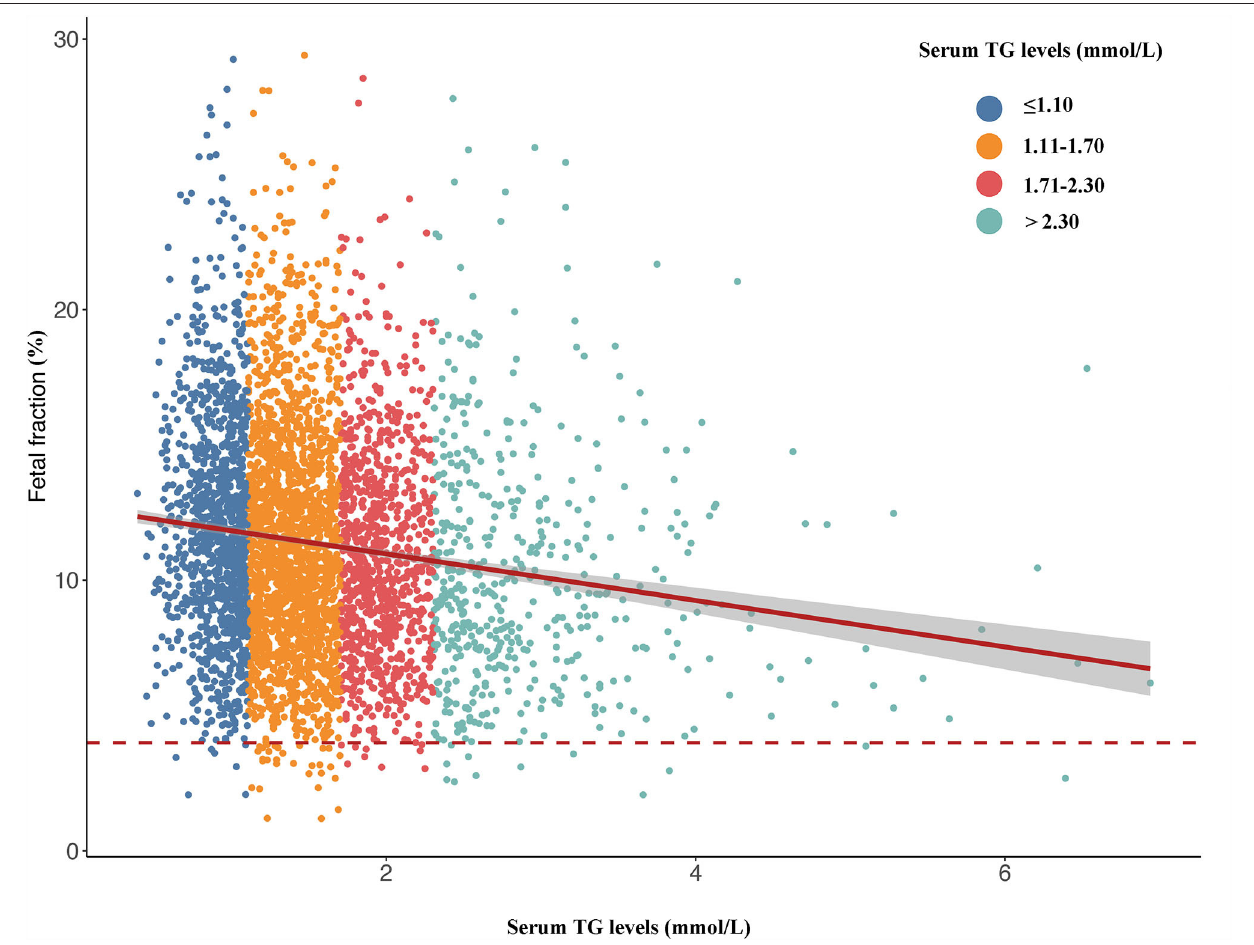
FIGURE 2 | Scatterplots of fetal fraction according to different groups of TG levels with lines of best fit from the linear regression.